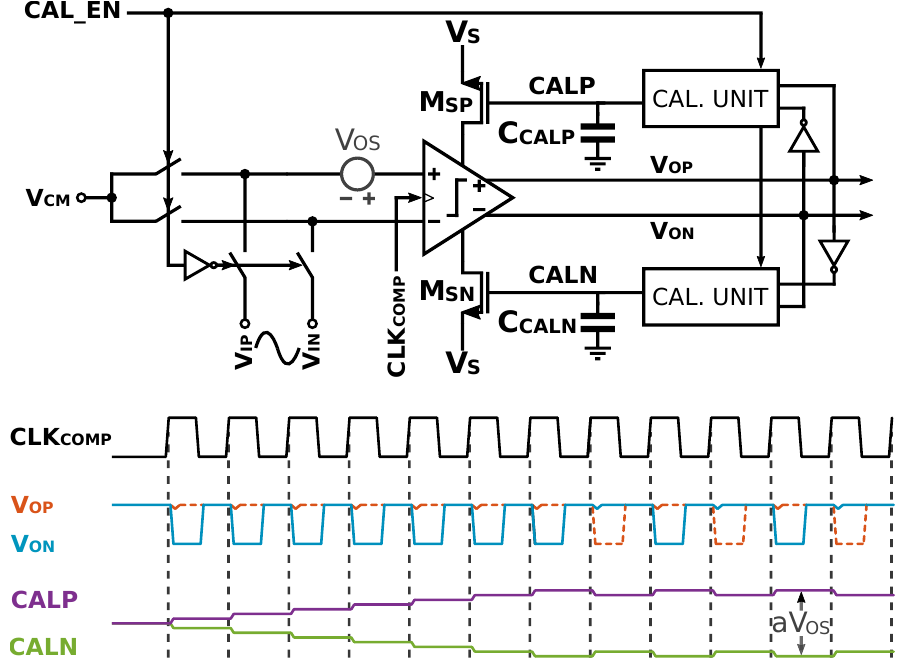
Figure 2. Top-level illustration of the proposed calibration ( top ) with its conceptual timing sequence ( bottom ).